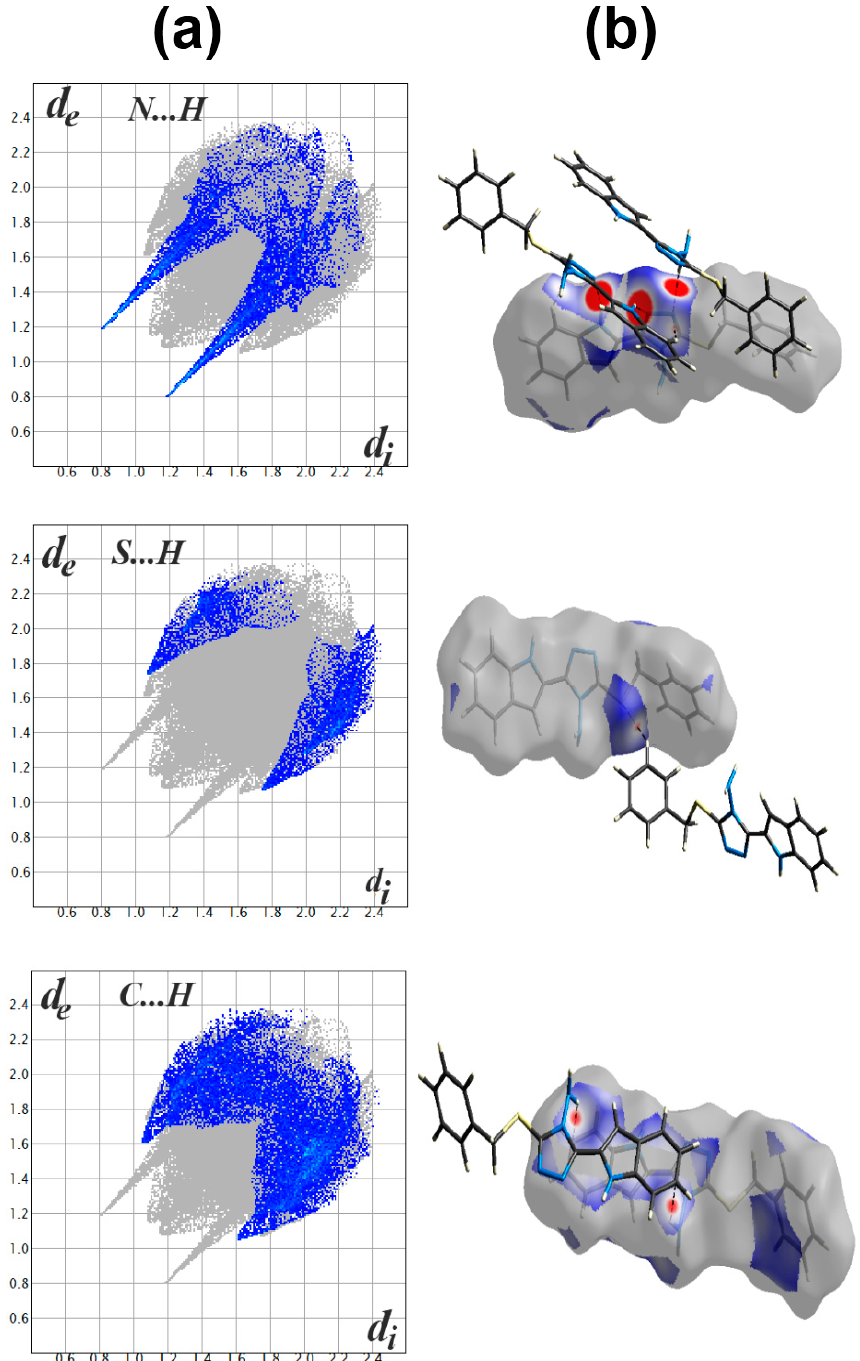
Figure 4. Fingerprint plot ( a ) and d norm surfaces ( b ) of the N...H, S...H and C…H contacts.